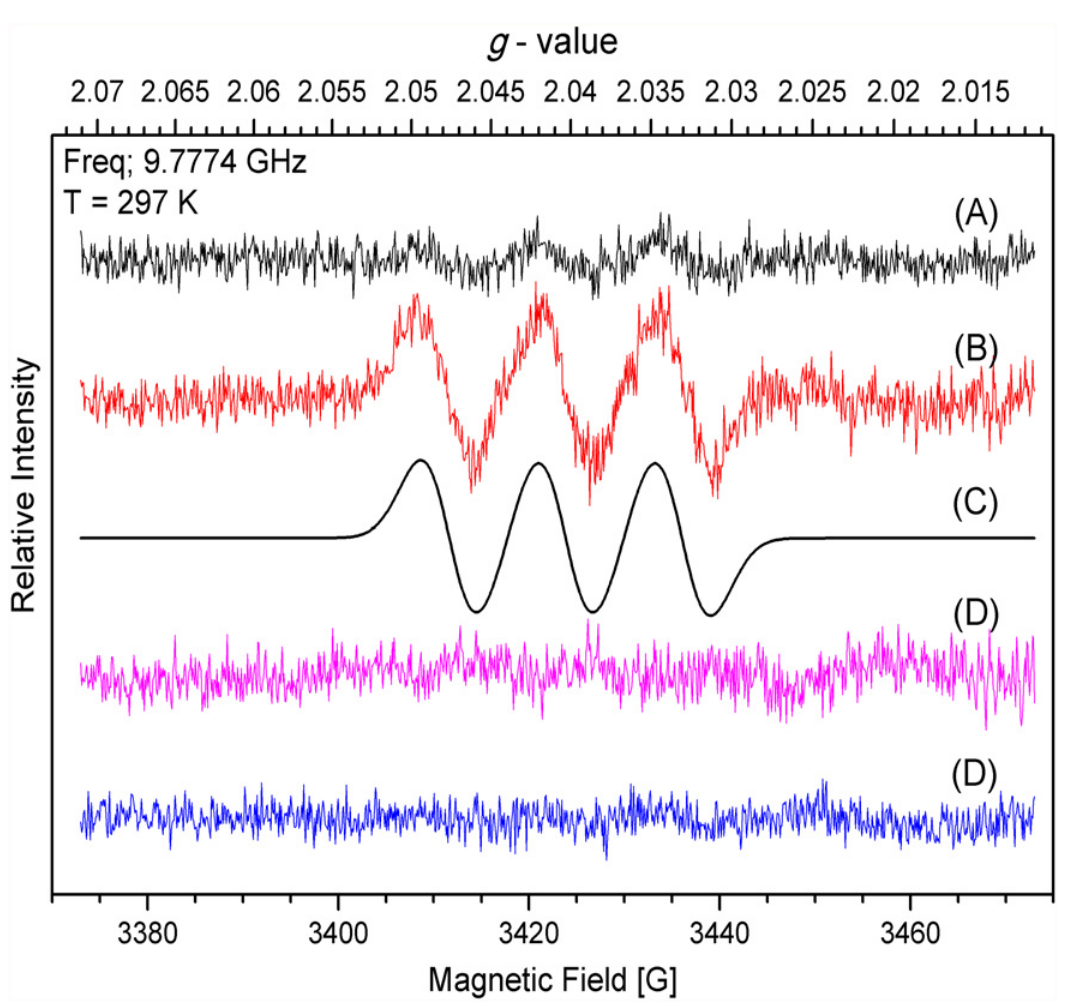
Fig 4. Nitric oxide detection by EPR in P. patens protonema growing in high nitrate. The EPR assay was performed as in Fig. 3 using plants that grew for seven days on A) Knop media, B) media added with 8.4 mM Ca(NO 3 ) 2 , D) Knop media added with 30 μ M sodium tungstate and E) media added with 8.4 mM Ca(NO 3 ) 2 and 30 μ M sodium tungstate. EPR spectra were recorded at approximately 9.8 GHz (X-band) and 100 kHz modulation (Microwave frequency, 9.777400 GHz for B) and microwave power, 2.0 mW; modulation amplitude: 0.3 mT; T, 297 K). Each graph is a representative spectrum of four independent experiments. C) represents the simulated spectrum of